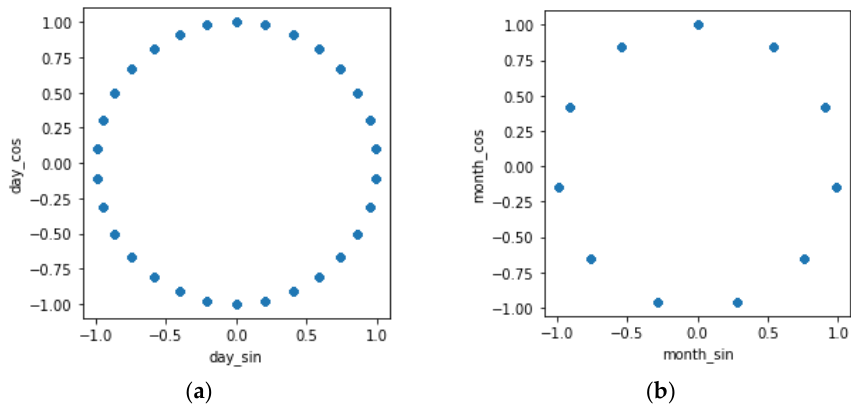
Figure 9. Cyclical representation of variables ( a ) day and ( b ) month.